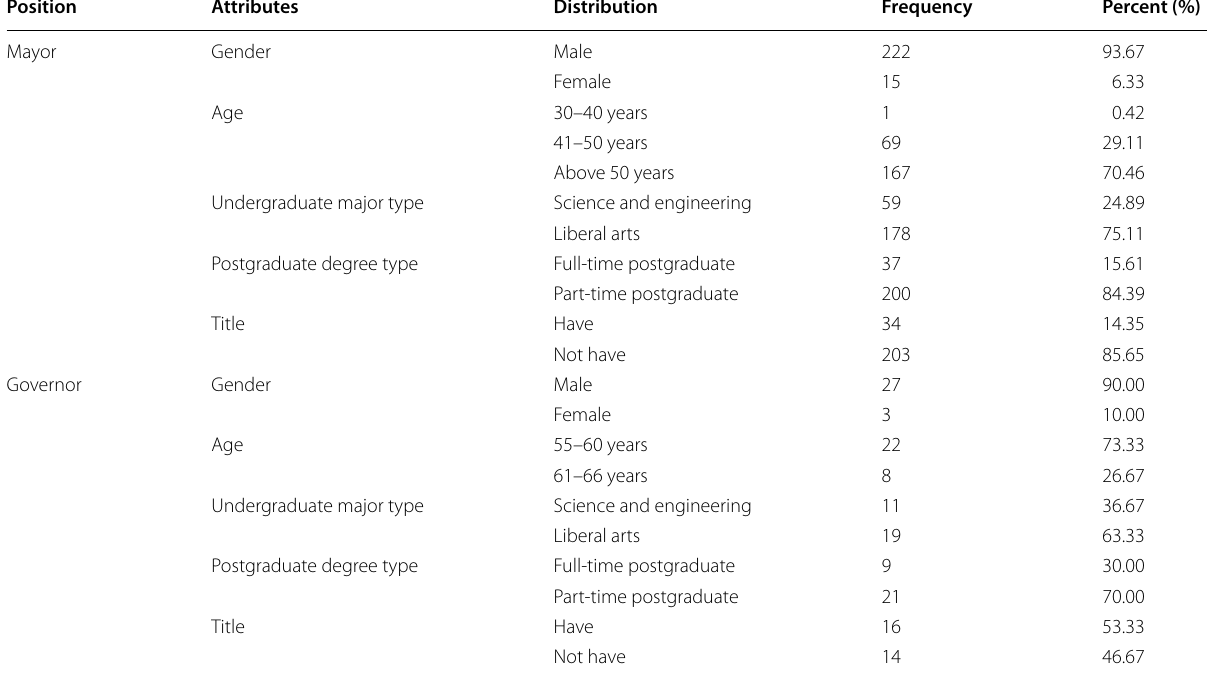
Mayor (prefecture level city), Governor (including the governors of provinces, autonomous regions, and municipalities directly under the central government). The mayor’s demographic analysis does not include officials’ relocation and sub-provincial cities. The governors demographic analysis does not include Hong Kong, Macau, Taiwan, and Tibet